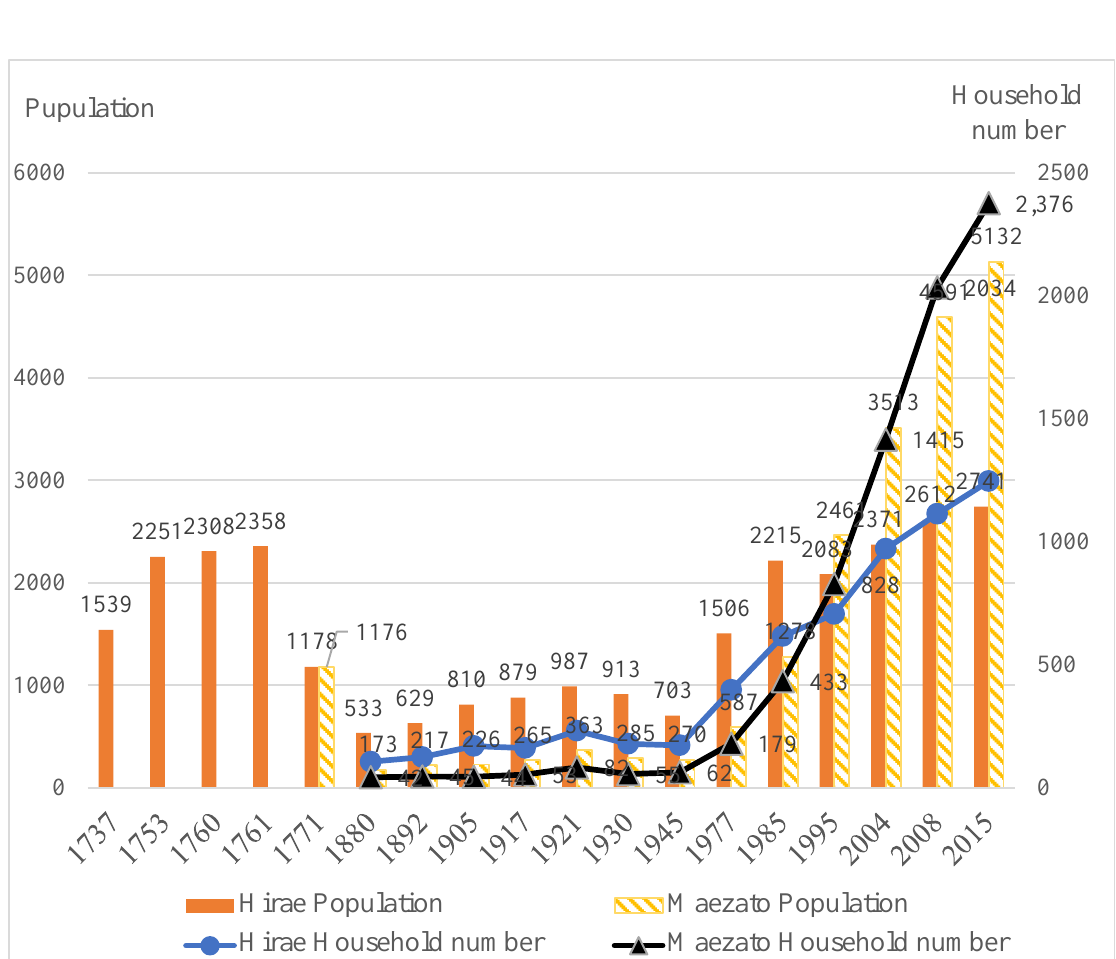
Figure 6. Population and household number increase.